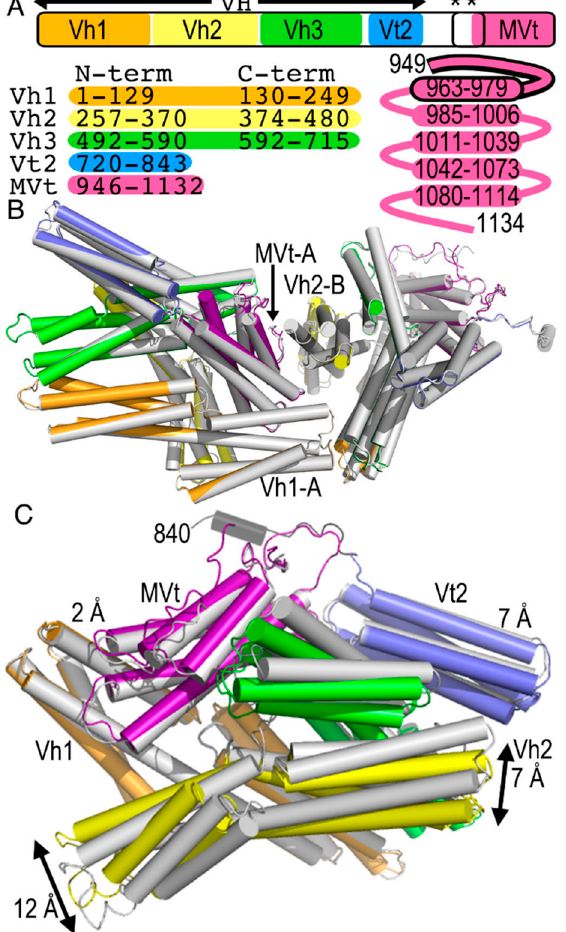
Figure 1. Metavinculin structure. ( A ) Top, Metavinculin domain structure. Metavinculin is organized in four domains colored spectrally (Vh1, orange; Vh2, yellow; Vh3, green; Vt2, blue) that make up the vinculin head (VH) domain that is connected to the metavinculin tail (MVt, violet) domain. The metavinculin-specific insert between vinculin residues 915 and 916 spanning part of the linker and the MVt domain is boxed and indicated by two asterisks. Left, bottom: Vh1, Vh2, and Vh3 have each two subdomains, and their residue range is indicated below the N-term and C-term labels (for N-terminal and C-terminal subdomain, respectively). Right, bottom: MVt is a five-helix bundle domain (residue range of each α -helix is indicated) with an isoform-specific (black borders) coiled coil and first α -helix H1’. ( B ) Superposition of the patient-derived Δ 954 metavinculin polypeptide chains in the asymmetric unit in the crystal (gray) onto the two wild type polypeptide chains in the asymmetric unit (Vh1, orange; Vh2, yellow; Vh3, green; Vt2, blue; MVt, violet). Inter-molecular interactions are indicated. ( C ) Superposition of the two polypeptide chains in the asymmetric unit from the structure of the patient-derived ∆ 954 metavinculin. Subunit A is shown in gray and subunit B is colored spectrally (Vh1, orange; Vh2, yellow; Vh3, green; Vt2, blue; MVt, violet) and its linker region that could be built only in subunit B is shown in black (residues 840–857). Relative domain differences are indicated.